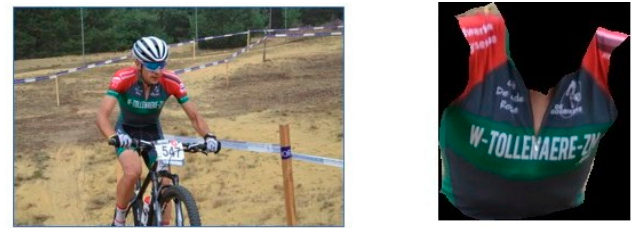
Figure 4. Illustration of the cropping and masking of the torso of a cyclist.